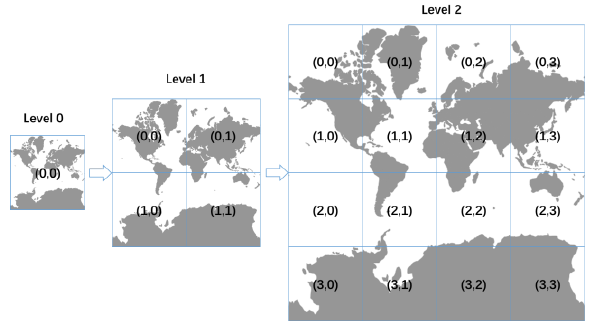
Figure 1. Quardtree spatial index of tiles from level 0 to level 2 As the level increases, the scale of the tile increases, the spatial range represented by a single tile decreases, and the spatial range relationship between adjacent levels of tiles is 1:4. The number of vector tiles at each level can be calculated according to